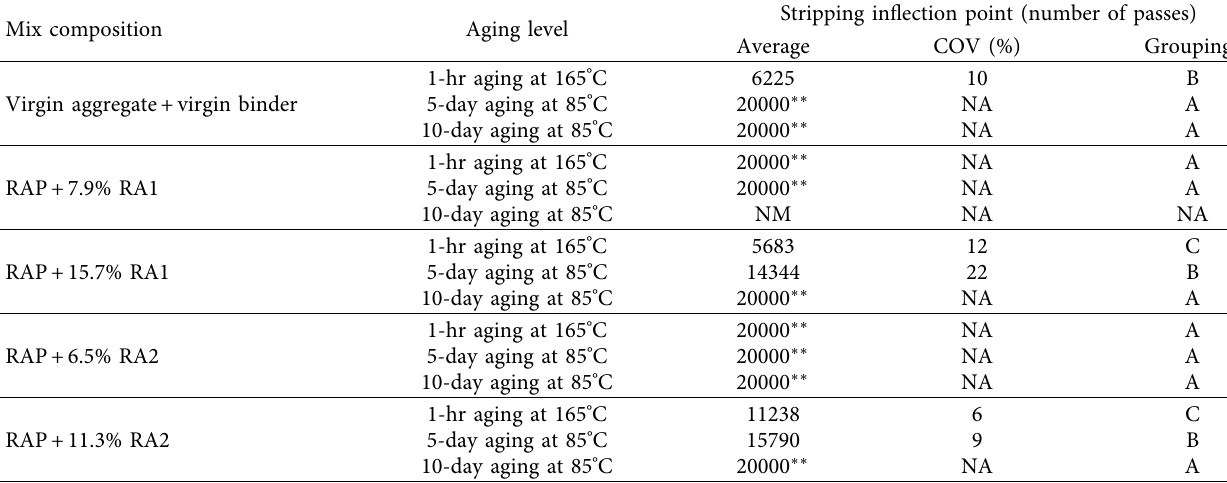
Table 8: LWT stripping inflection point results, 50 ° C